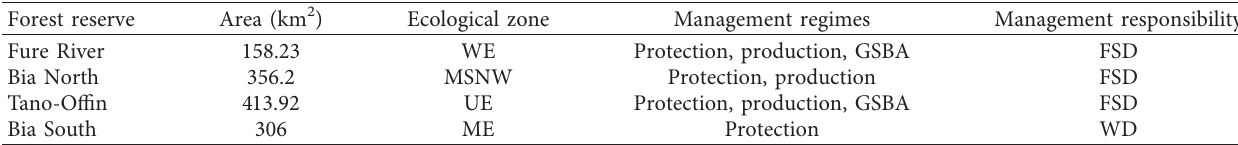
Figure 1: Map of study area. The selected reserves are coloured green. Table 1: Study areas and their management